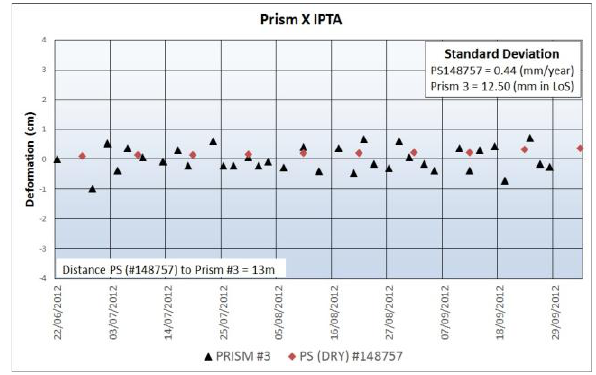
Figure 4. Time-series deformation profiles for a reflecting prism and corresponding PS (IPTA) for a cut slope (N4E mine) during a period of three months.